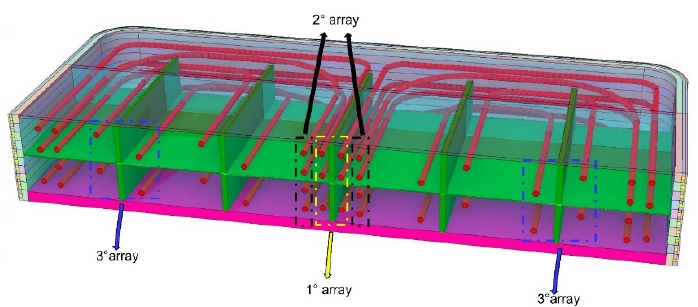
Figure 2. Different tubes arrays of the BZ cooling system.